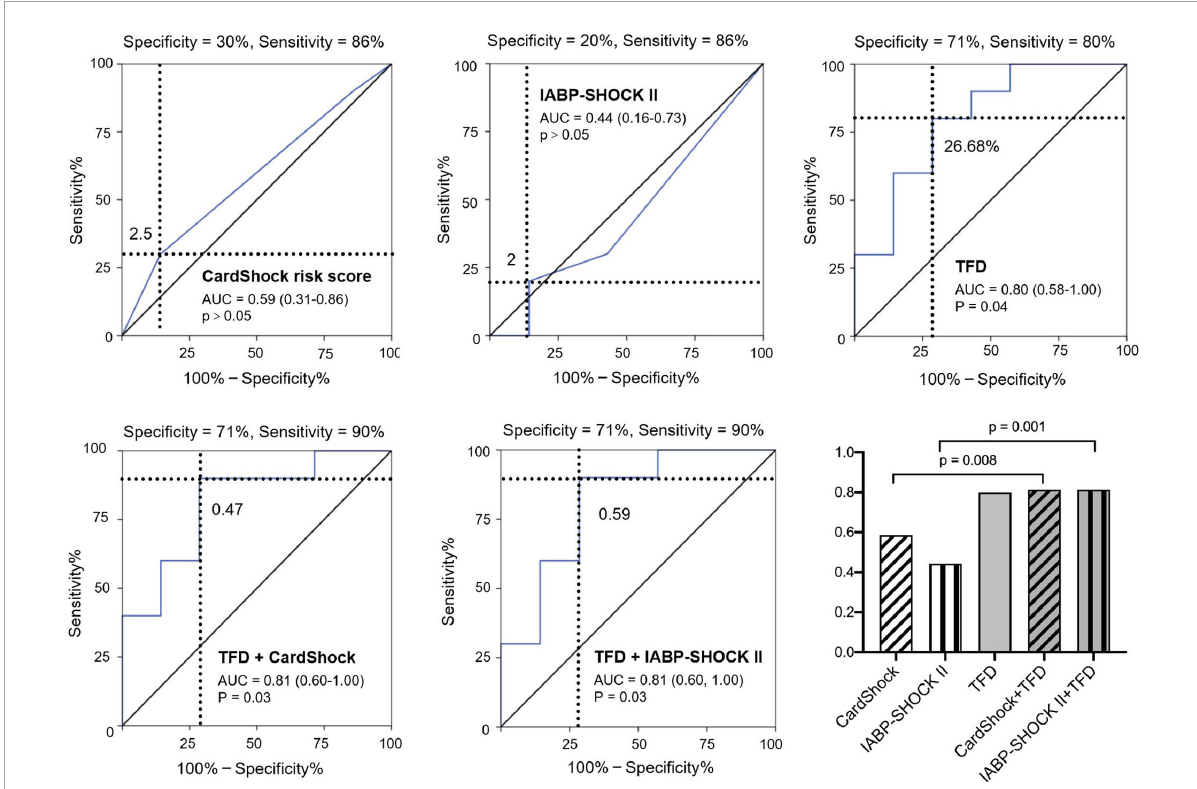
FIGURE3 Predictive value of post-infarction MACE in patients with CS using CardShock risk score, IABP-SHOCK II risk score, TFD, combination of CardShock risk score and TFD, and combination of IABP-SHOCK II risk score and TFD. TFD added significant predictive information to these models. AUC: area under the receiver-operating characteristic curve; TFD, total FDG uptake deficit; MI, myocardial infarction; MACE, major adverse cardiac events; CS, cardiogenic shock.